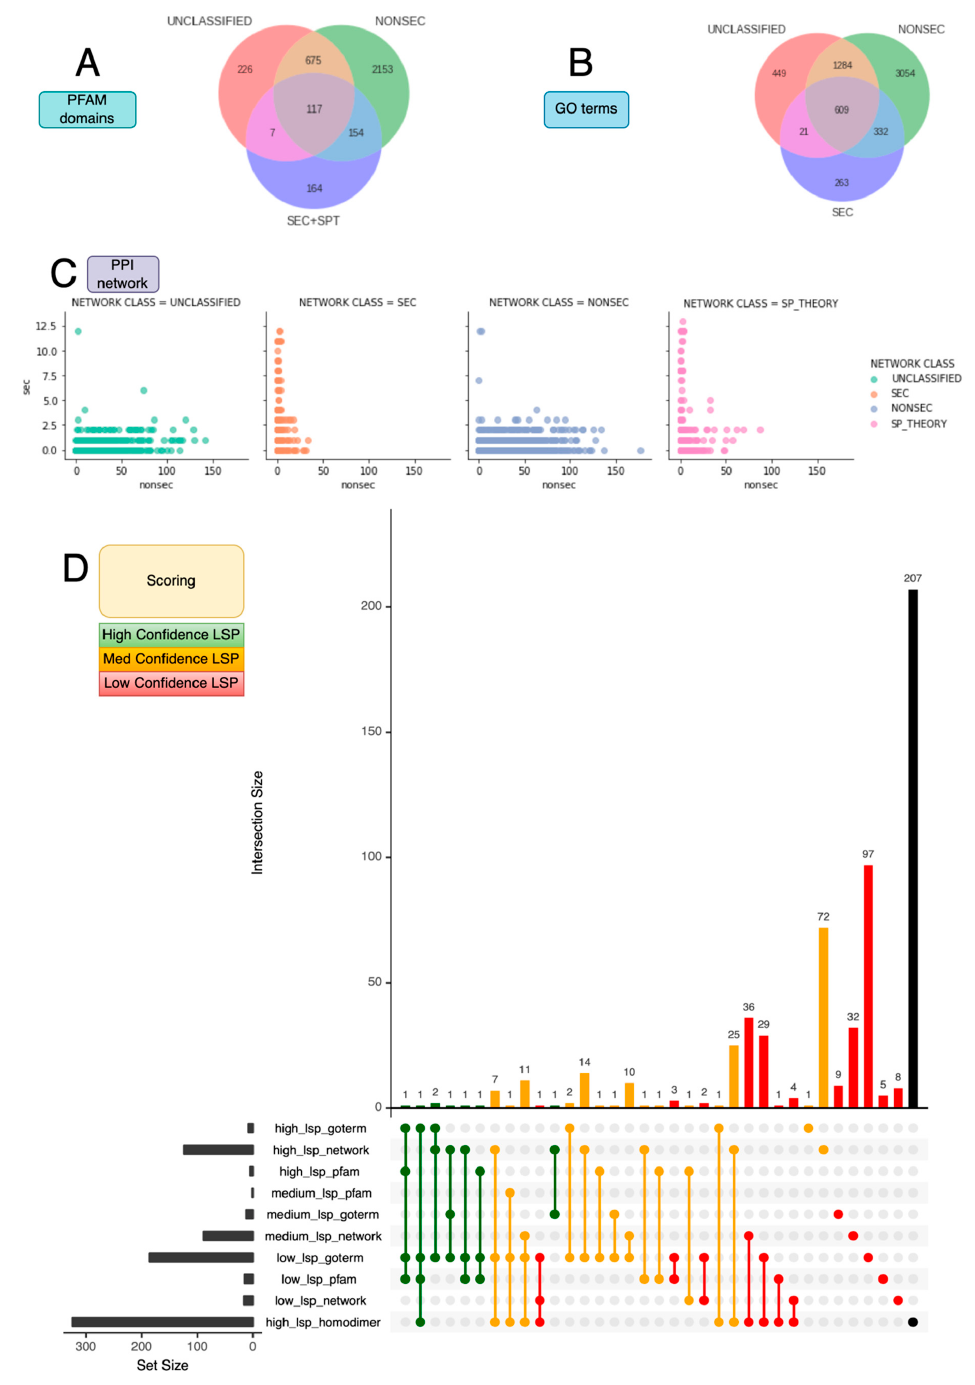
Figure 2. LSPDB Scoring. Overview of the individual evidence categories. ( A ) Venn diagram of common PFAM domains from the combined SEC/SPT, NONSEC, and UNCLASSIFIED LSPDB classes. ( B ) Venn diagram of common GO terms from the combined SEC/SPT, NONSEC, and UNCLASSIFIED LSPDB classes, and ( C ) profile of SEC and NONSEC interactions of each LSPDB class according the LSPDB PPI network. ( D ) UpSet plot of the overlapping proteins that meet the individual confidence criteria as outlined in Table 1 to form the high-confidence set (green—8 proteins), medium (orange—149), and low (red—227). A further 207 (black) are noted as homodimers without any other